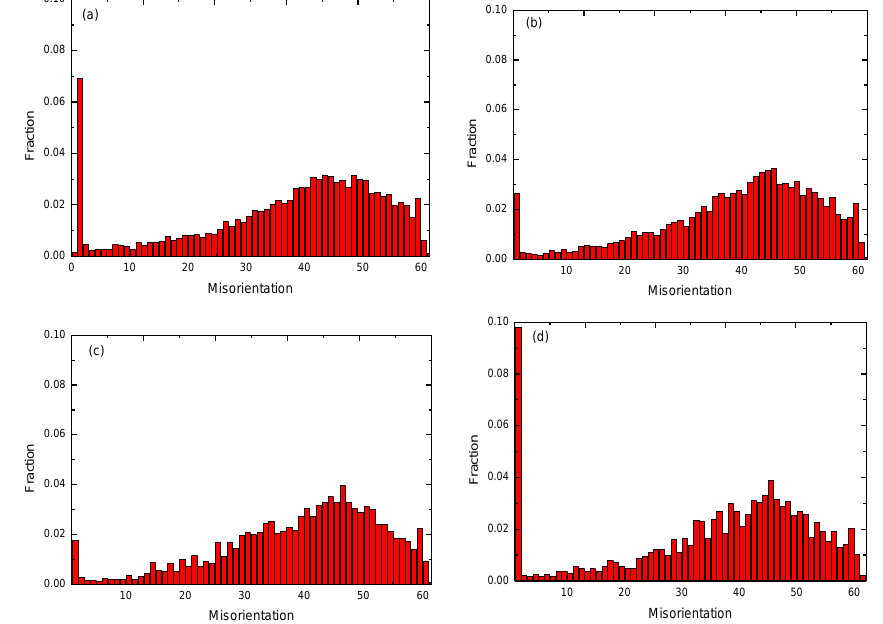
Figure 6. The misorientation angle at different deformation from T1 to T4 ( a ), ( b ), ( c ) and ( d ) respectively for the true strains with 0.41, 0.69, 1.61 and 2.17.